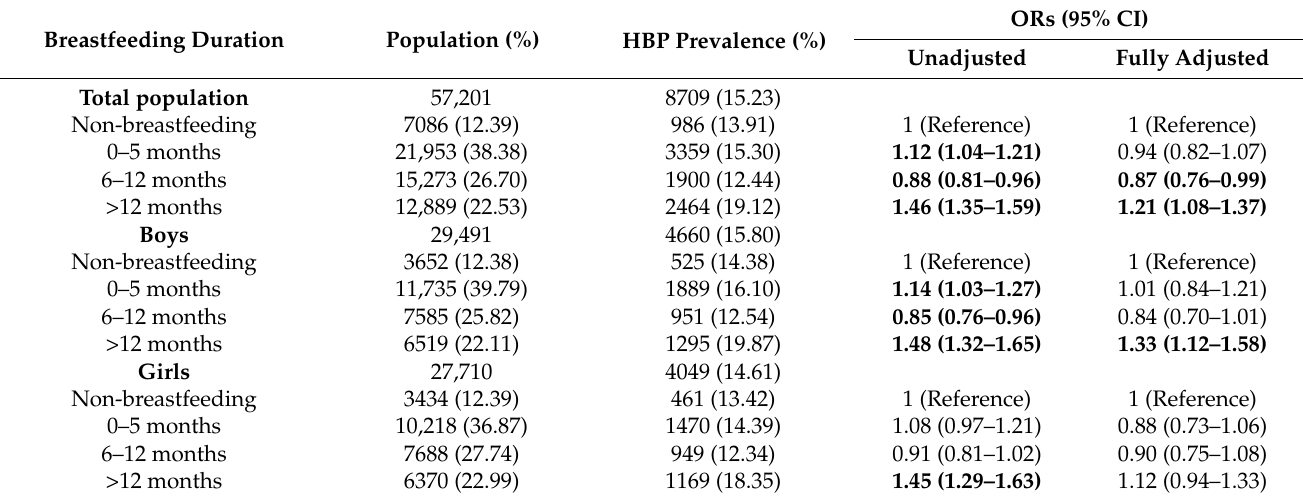
Table 3. Multivariate odds ratios (ORs) and 95% confidence intervals (CIs) of HBP by breastfeeding